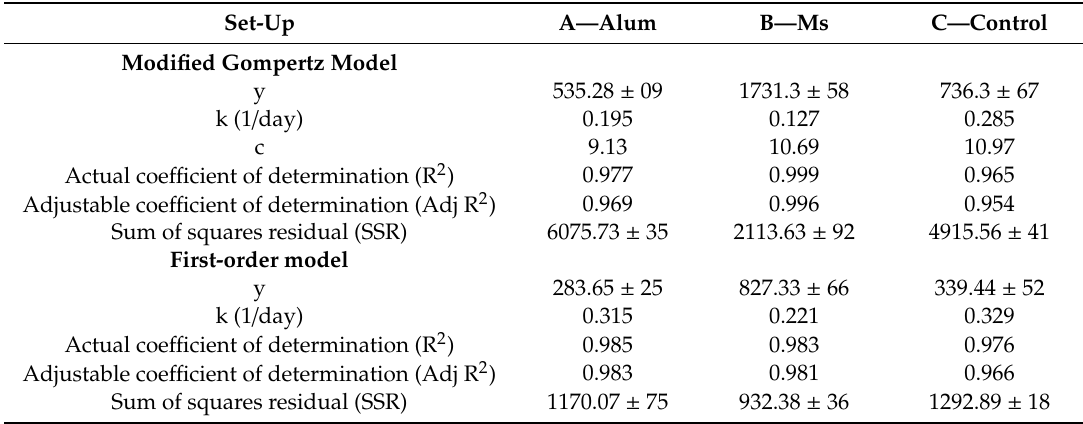
Figure 10. Cumulative biogas production for Modified Gompertz kinetic model. Table 3. Results of Modified Gompertz and first-order kinetic constants.